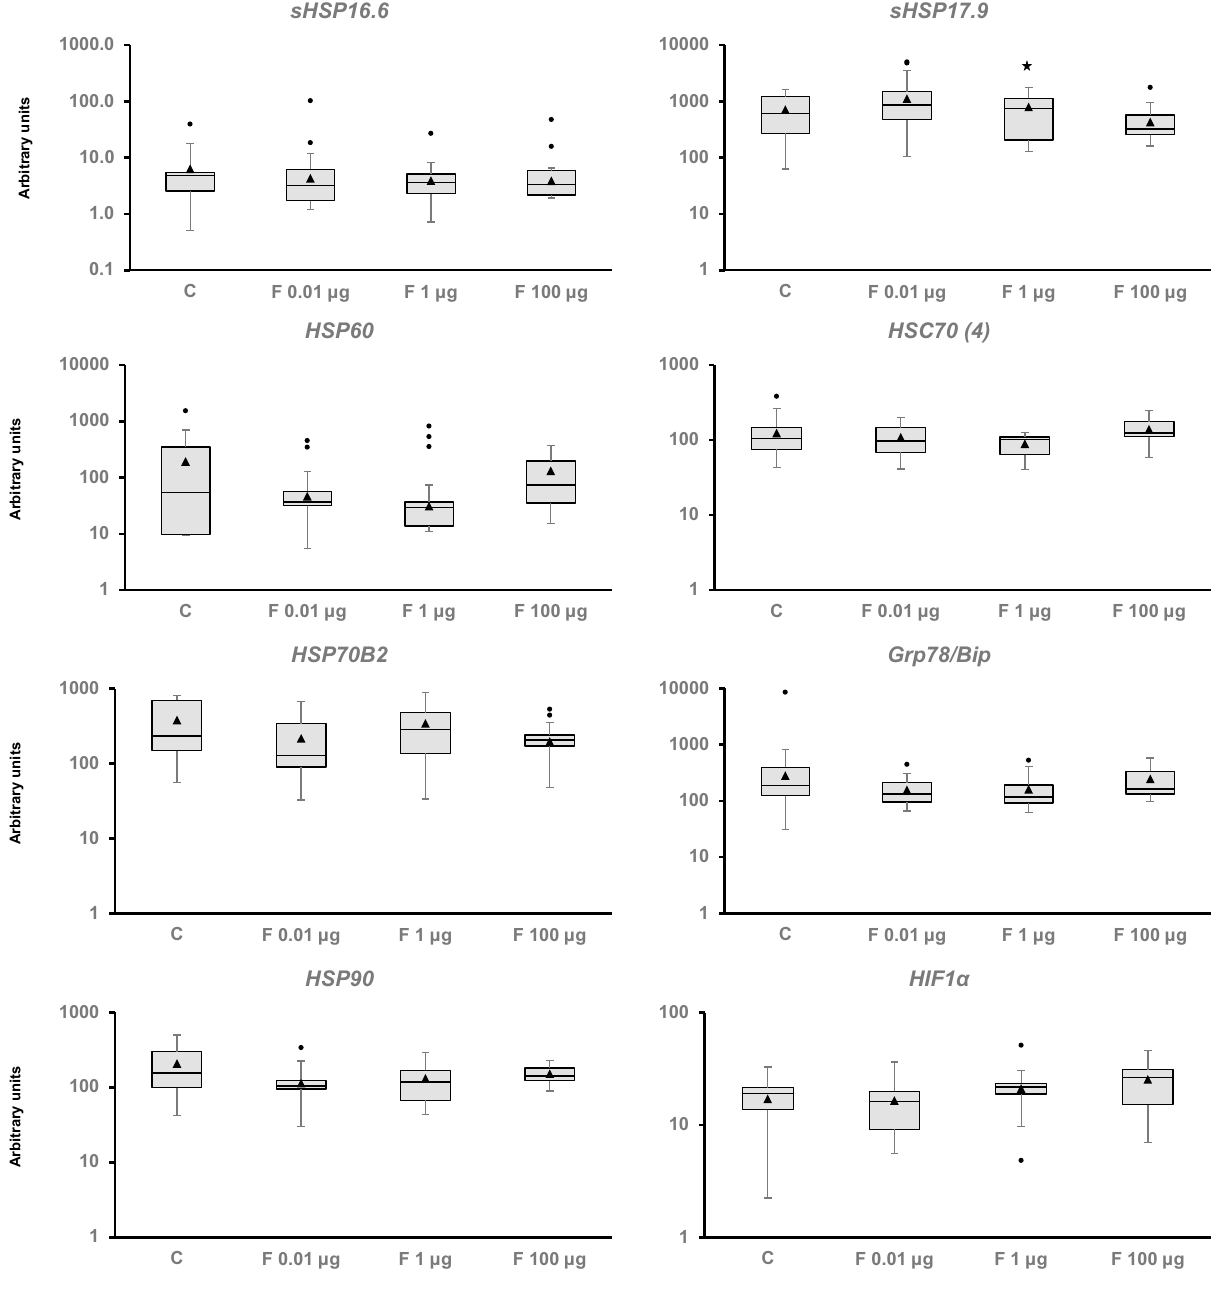
Figure 5. Transcriptional activity of stress ( small heat shock protein 16.6 [ sHSP16.6 ], small heat shock protein 17.9 [ sHSP17.9 ], heat shock protein 60 [ HSP60 ], heat shock cognate 70 4 [ HSC70 (4) ], heat shock protein 70 B2-like [ HSP70B2 ], glucose regulated protein 78/binding immunoglobulin protein [ Grp78/BiP ], and heat shock protein 83 [ HSP83 ]) and hypoxia-inducible factor-1 alpha [ HIF1α ]) genes in adult snails. The animals were exposed for one week to Fenoxycarb at 19 °C. Transcriptional activity was quantified by RT-PCR using ribosomal protein L10 ( rpL10 ), actin ( Act ), 6-phosphofructo-2-kinase/fructose-2,6-biphosphatase 2 ( PFKFB2 ), and glyceraldehyde-3-phosphate dehydrogenase ( GAPDH ) as reference genes. The comparison was performed with the solvent-exposed controls. Whisker boxes are shown. Each box corresponds to 12 individuals. The median is indicated by the horizontal line within the box, and the 25th and 75th percentiles are indicated by the boundaries of the box. The highest and lowest results are represented by the whiskers. The small triangle inside the box denotes the mean, and the outliers are shown (circles). Significant difference relative to the control (asterisk) is indicated (p <